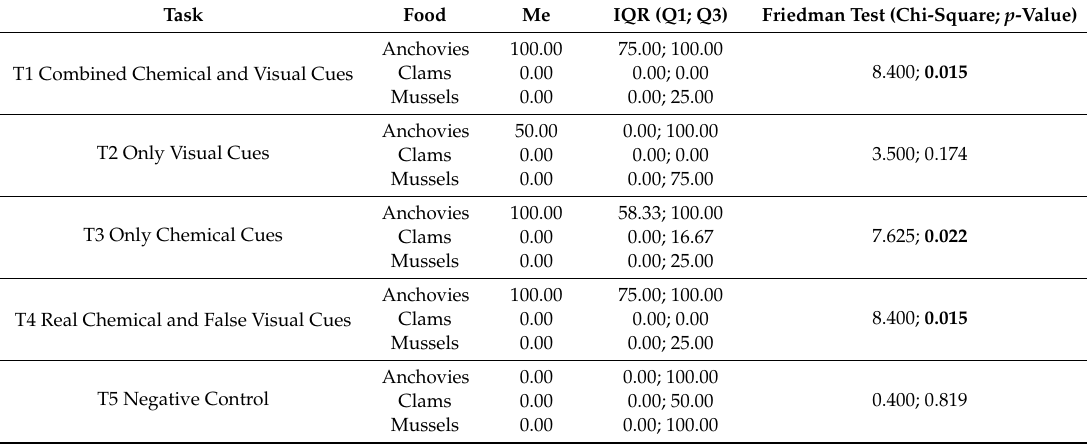
Table 4. Food choice under di ff erent tasks in Octopus vulgaris (percentage). Task Food Me IQR (Q1; Q3) Friedman Test (Chi-Square; p